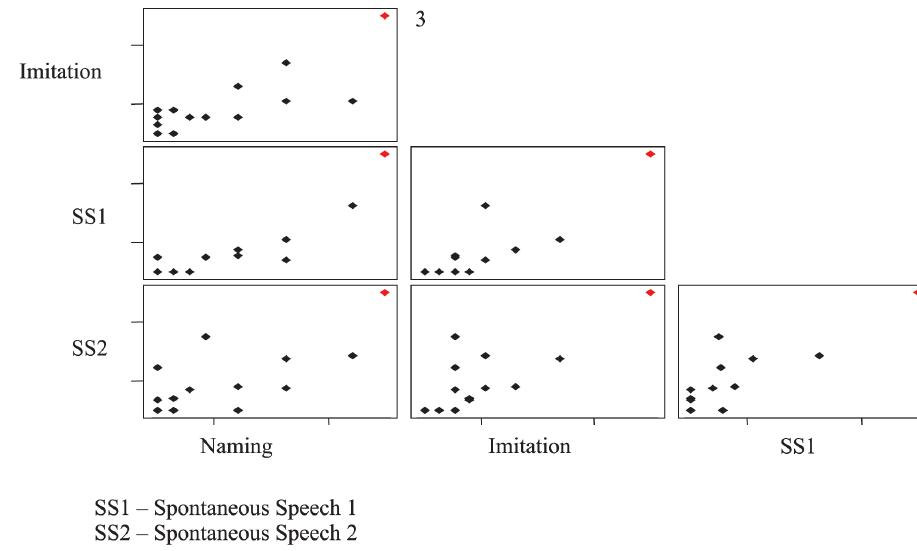
Figure 6 - Dispersion of proportions of distortion occurrences in the Group with Phonological Disorders.